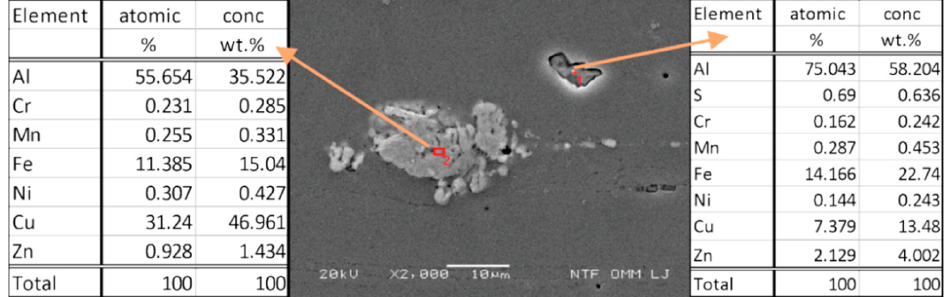
Figure 10. SEM image and chemical analysis of precipitates.